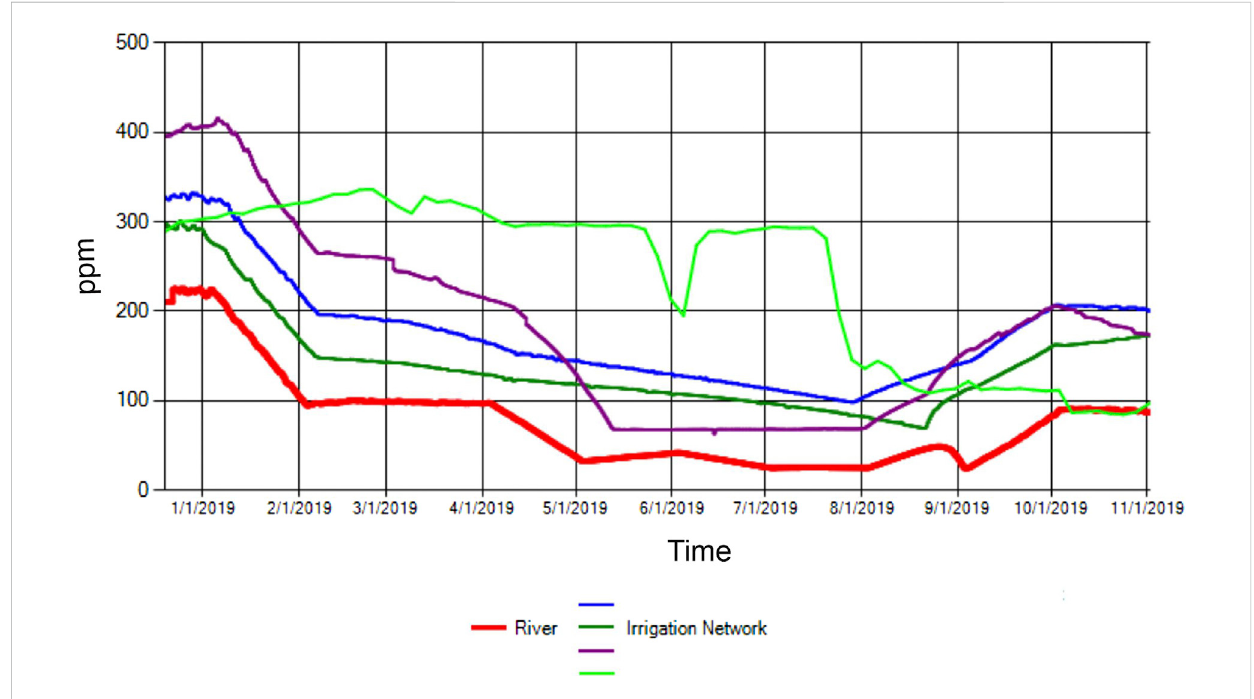
FIGURE 14 Cohesive Sediment - concentrations (ppm) as a function of time.